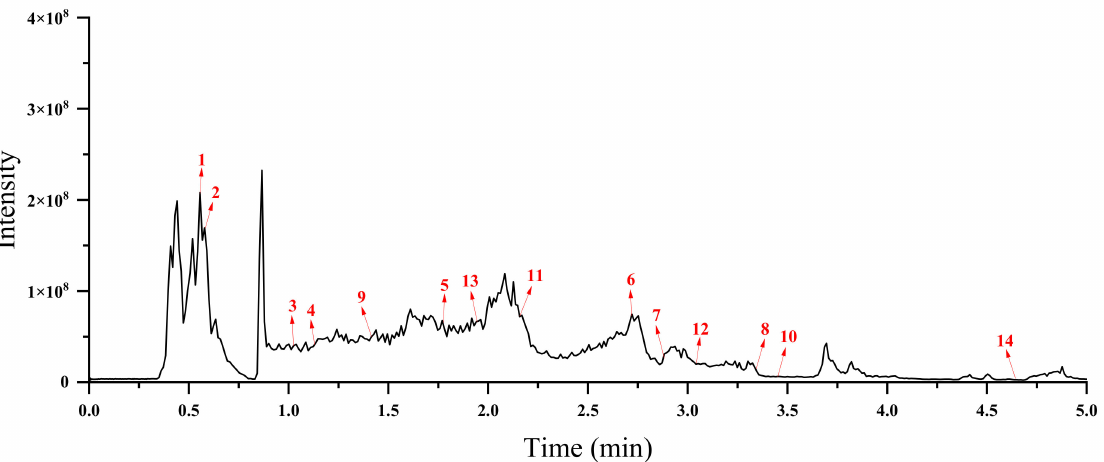
Figure 7. Total ion current chromatogram (TIC) of EAF fraction of crude extract from quinoa at negative ion